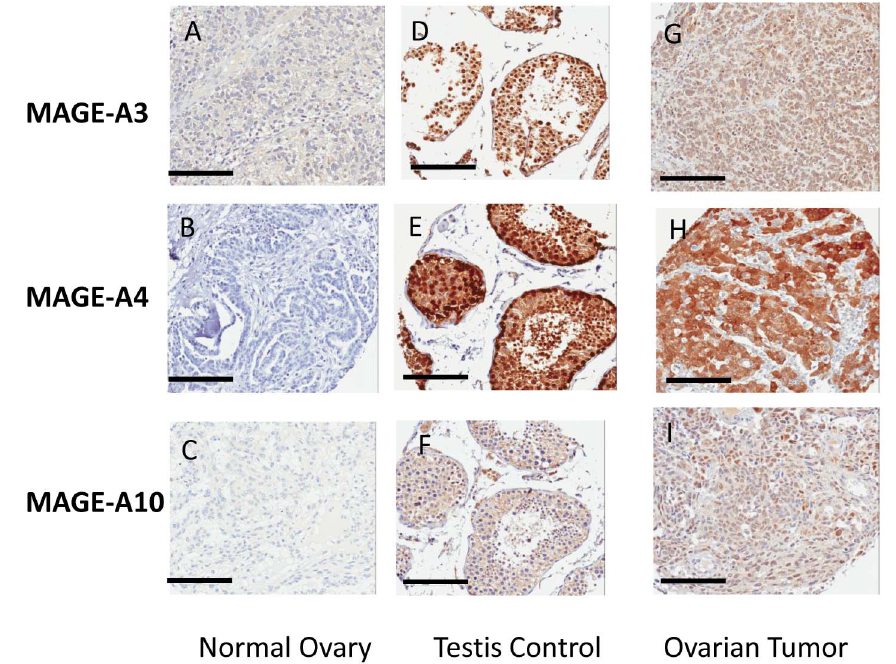
Figure 1. A–I: Immunohistochemical staining for MAGE. Specimens were stained with polyclonal antibody for MAGE-A3 (X20), clones 57b and A3 hybridoma supernatants for MAGE-A4 and MAGE-A10, respectively (x15). Specimens from the normal ovary and testis were used as negative and positive controls, respectively. A–C: Staining of the normal ovary showing no reactivity. D–F: Staining of the testis showing seminiferous tubules with strong intratubular staining, and absent non-specific reactivity. G–I: Staining of ovarian tumor demonstrating strong cytoplasmic and/or nuclear staining patterns. doi:10.1371/journal.pone.0104099.g001 PLOS ONE |